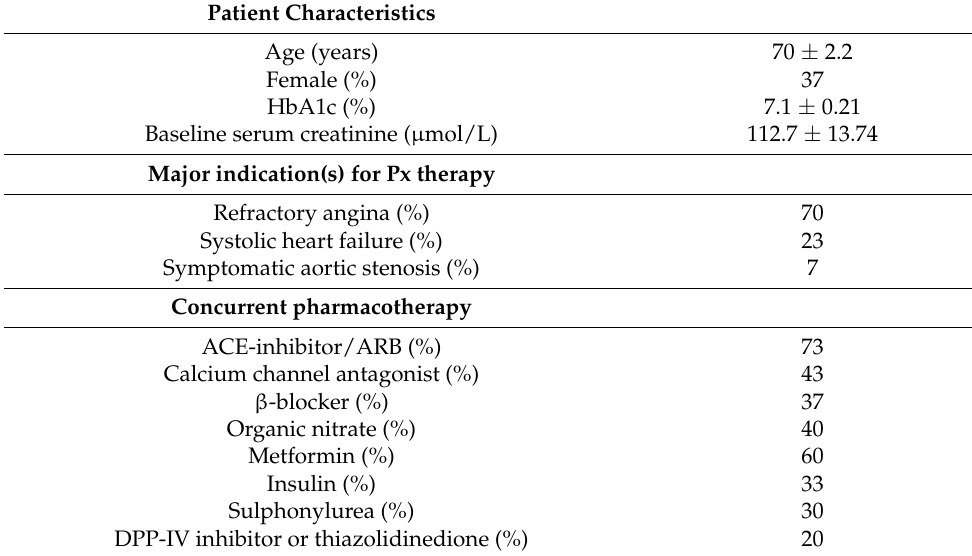
Table 1. Baseline clinical characteristics (n = 30).